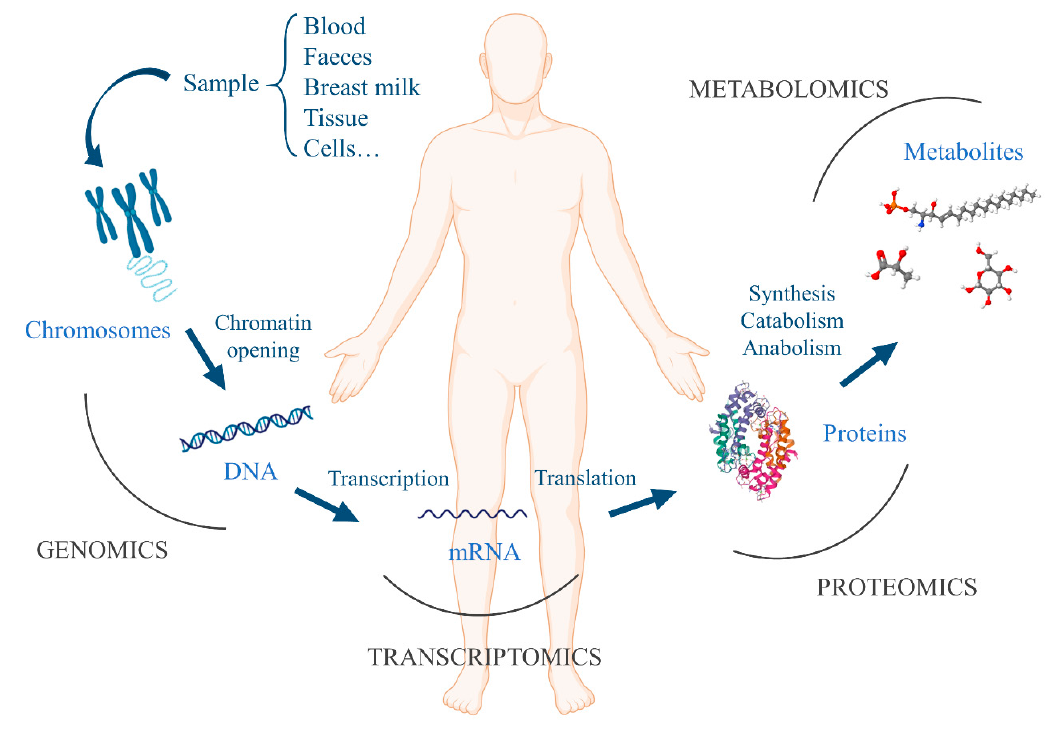
Figure 3. Main omics techniques: genomics, transcriptomics, proteomics, and metabolomics.